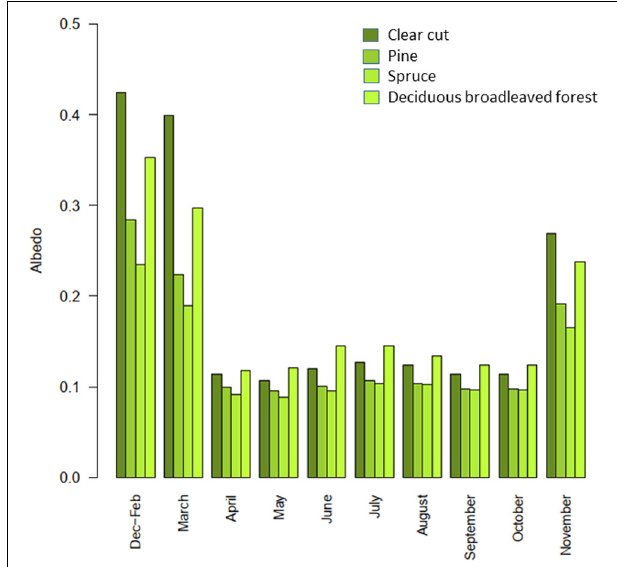
FIGURE 2 | Monthly mean albedo estimated from multi-source national forest inventory data (MS-NFI) and MODIS satellite